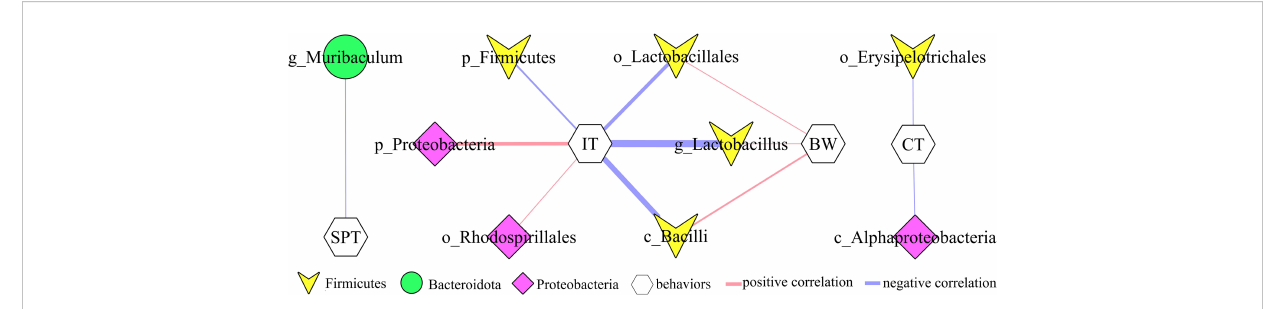
FIGURE 4 Correlations between differential bacterial taxa and depressive-like behaviors. SPT, sucrose preference; IT, immobility time; CT, center time (%); BW, body weight.